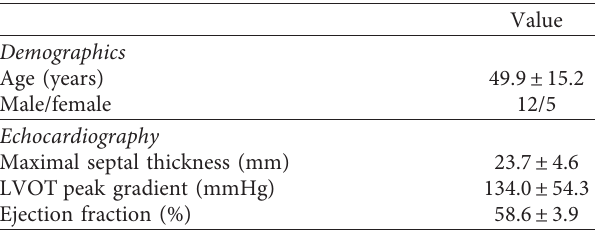
Figure 2: Myocardial biopsy process of the Liwen procedure. Under the guidance of echocardiography, the biopsy needle was inserted into the puncture sheath from the apex to the central septum and took biopsies. (a) LMB illustration. (b) Echocardiographic image during LMB. (c) The process of LMB. (d) The biopsy needle with specimen. Table 1: Baseline patient characteristics ( n � 17). Table 2: Results and complications of LMB( n �